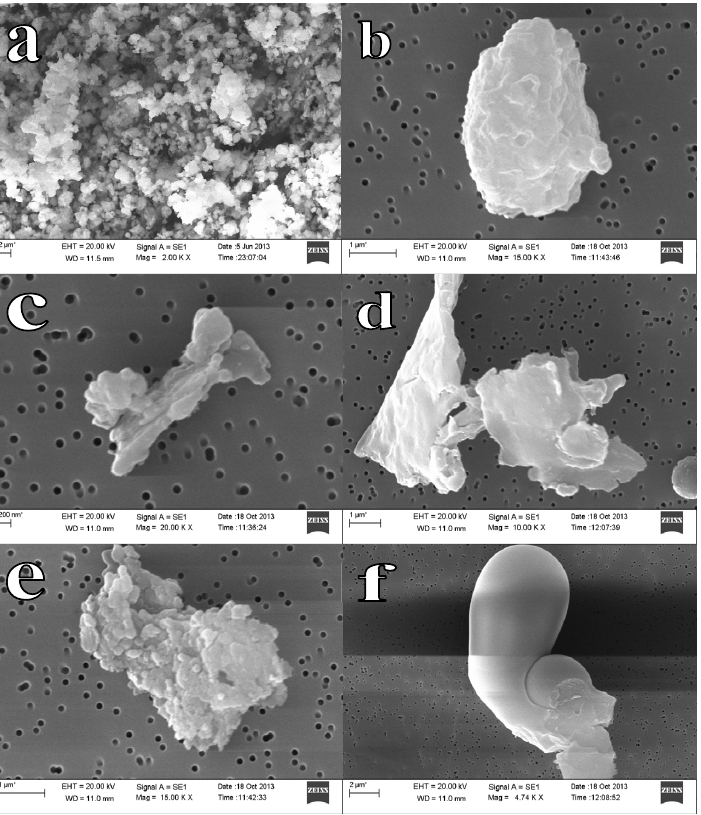
Figure 5. Micrographs of fine particle formed by power plant CFB boiler. ( a ) micrograph of a great quantity of fine particles; ( b – d ) main morphology of irregular fine particles; ( e ) particles with ultrafine particles adsorbed on the surface; ( f ) partially melted particles.